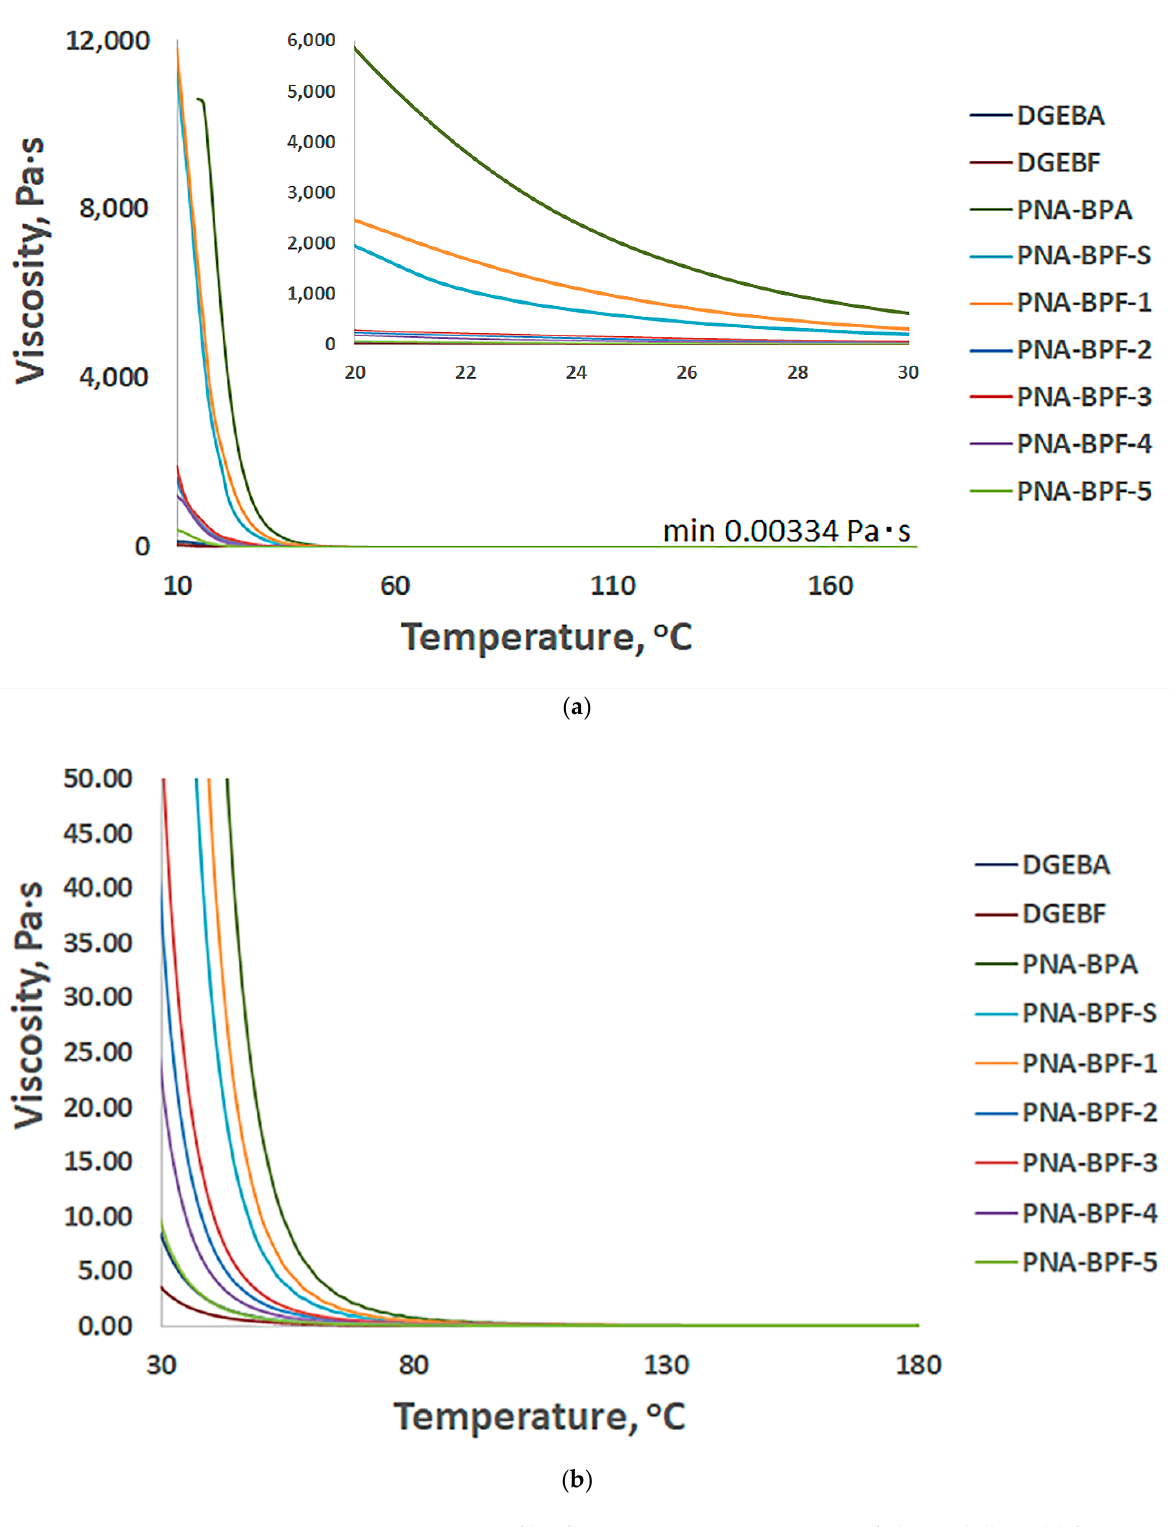
Figure 7. Temperature profile of viscosity versus temperature of obtained PhER, ( a ) from 10 to 180 °C and from 22 to 26 °C , and ( b ) from 30 to 170 °C, respectively. PNA -BPA — epoxy resin obtained by the method in [52] at a ratio of HCP:BPA equal to